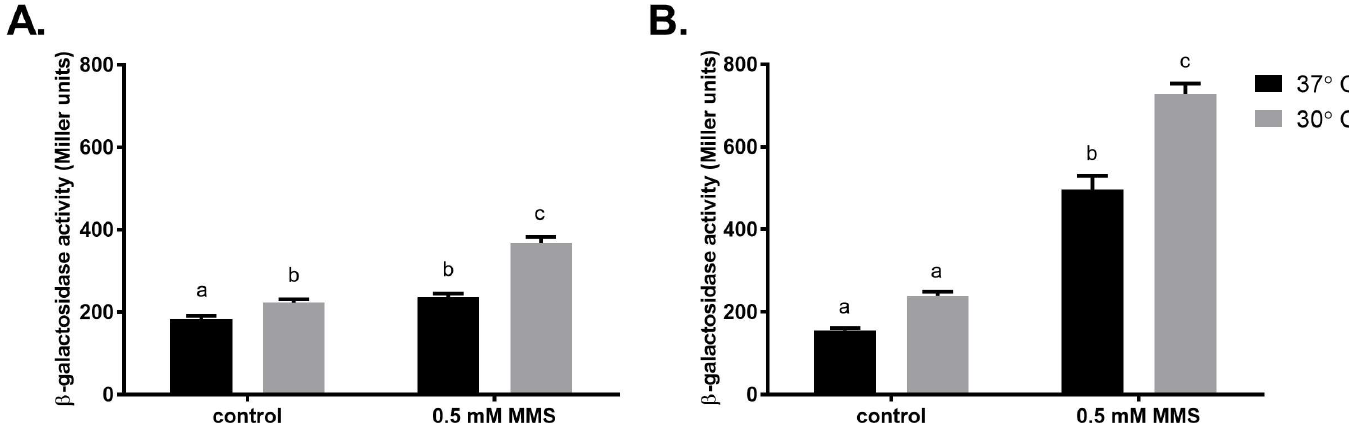
Fig 11. Effect of incubation temperature on transcription from the P . aeruginosa dinB promoter. β -galactosidaseactivity expressedfrom the dinB promoter- lacZ reporter was measured in the P . aerugionsa wild-type(A) and in its alkA- deficientderivative (B) incubatedat 37˚C (black) and 30˚C (grey) overnightin liquidLB medium supplemented with 0.5 mM MMS or not (control). Data representsthe mean ( ± SE) values. Letters indicatehomogeneous groups accordingto ANOVA followedby Bonferroni’s multiple comparisons test ( P <